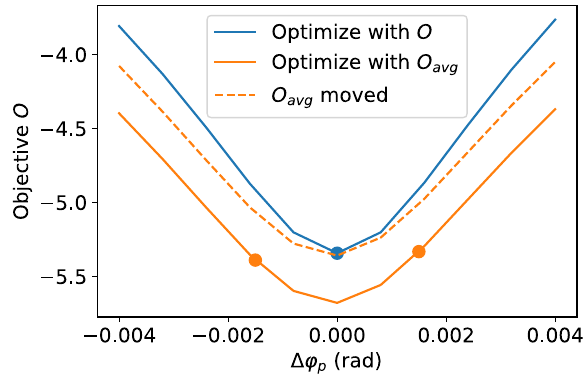
Fig. 4 Robustness of the iSWAP gate with respect to the control parameter φ p . For different Δ φ p , we compute O ð add ð ~ p ; φ p ; Δ φ ÞÞ . The blue and orange dots mark the Δ φ p values used to perform the optimization. The orange dotted curve is a translation of the orange curve. The curvature of the orange dotted curve is smaller than that of the blue curve. Therefore, the parameters obtained from the robustness optimization are more